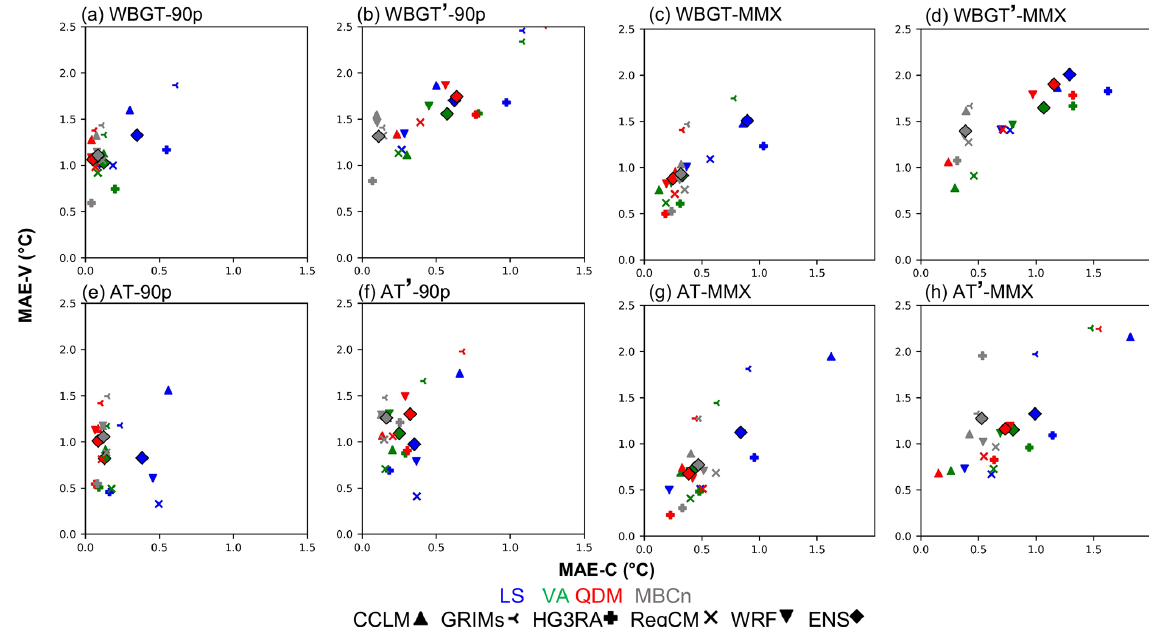
Figure 4. The MAE over South Korea (land only) for the calibration period (1979–1996, x axis) and validation period (1997–2014, y axis) in terms of the (a, b, e, f) 90p and (c, d, g, h) MMX from (a, c) WBGT, (c, d) WBGT (cid:48) , (e, f) TW, and (g, h) TW (cid:48) . The different colors stand for different BC methods, and the different markers stand for different